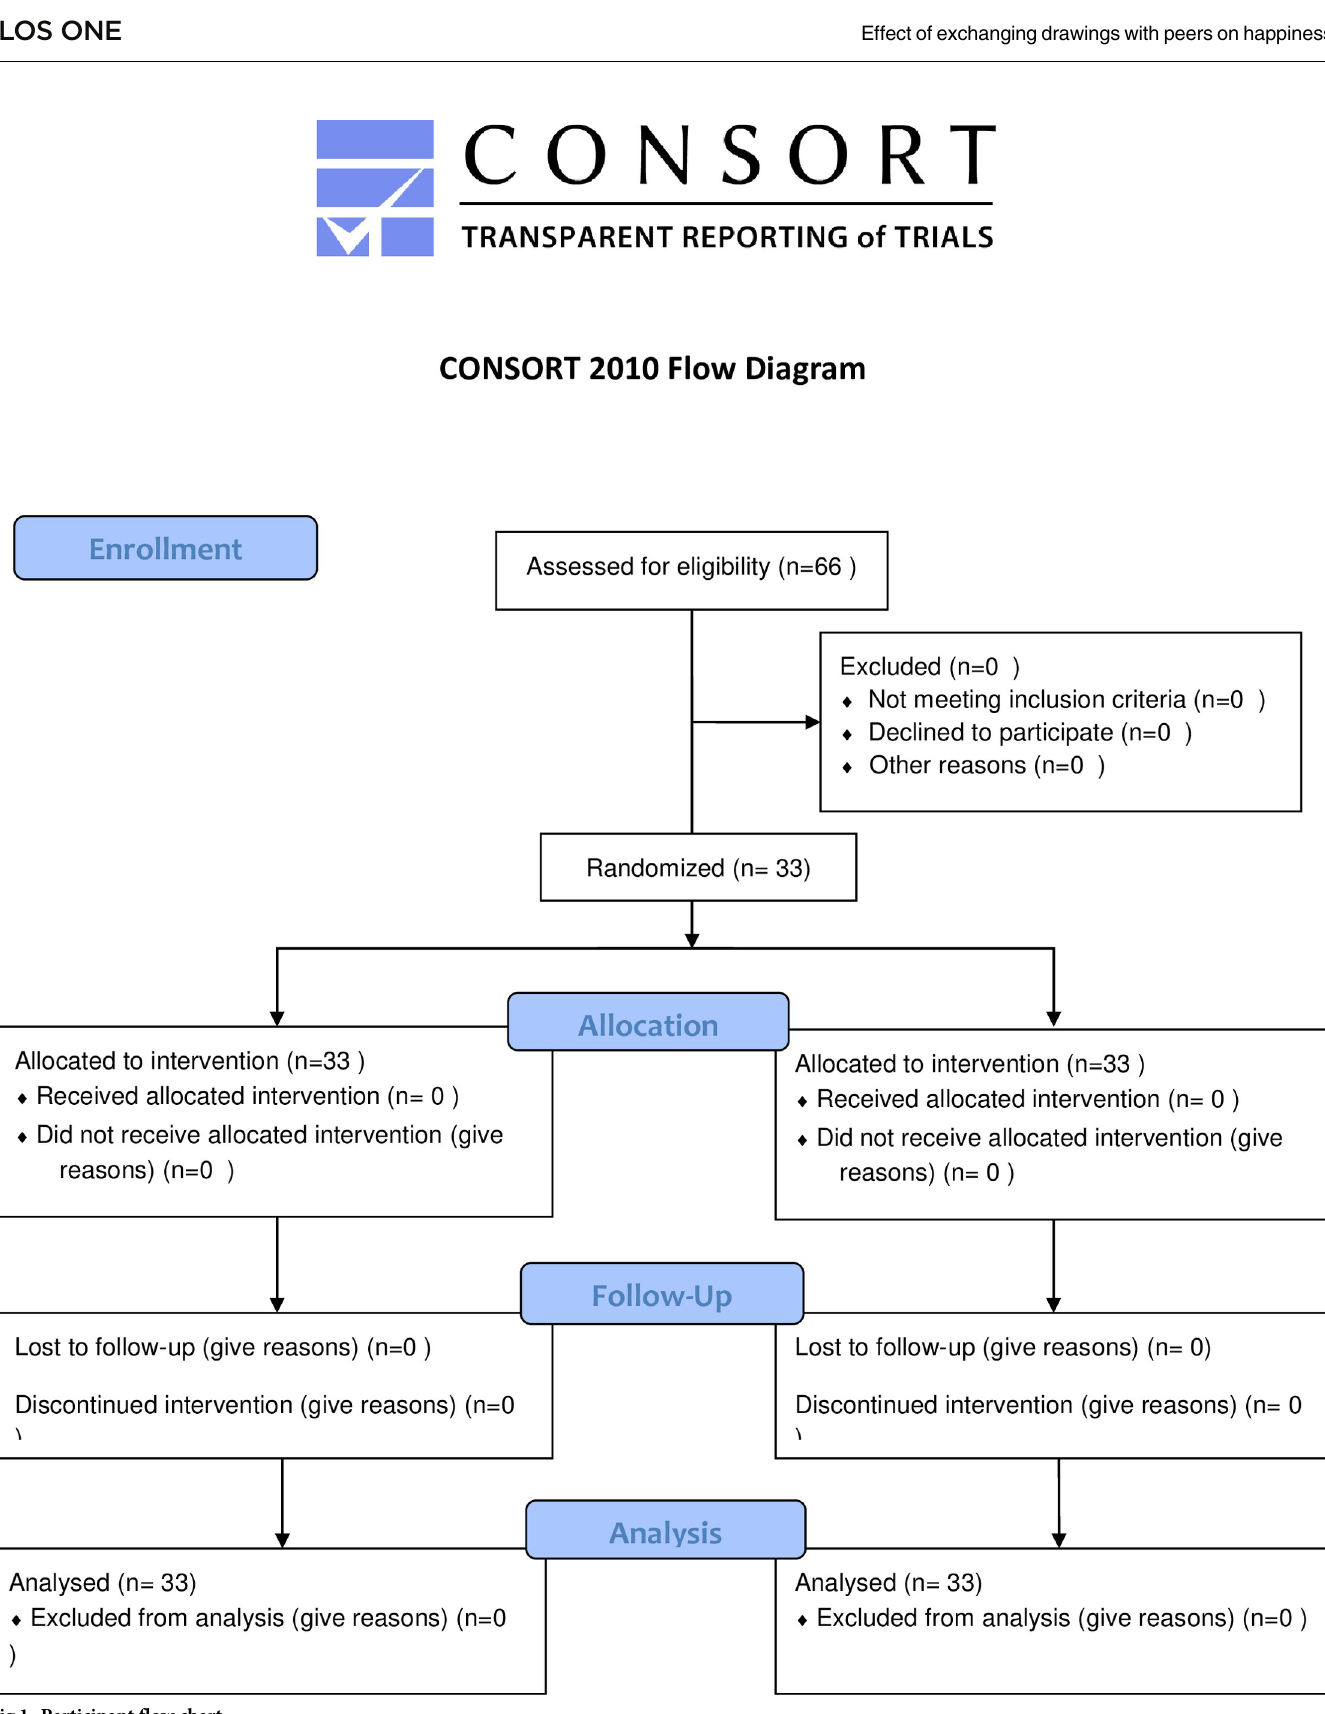
Fig 1. Participant flow chart.